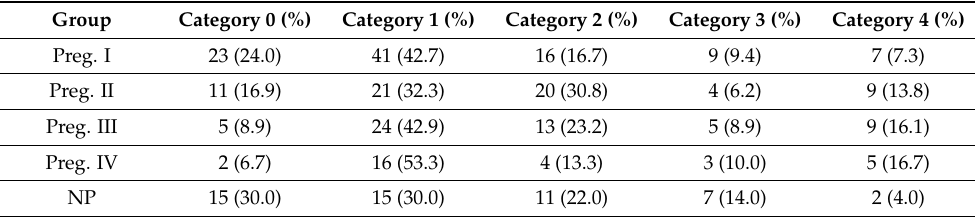
Table 5. Lactobacillus ( LB ) counts in the saliva of pregnant women at different gestational ages compared with non-pregnant